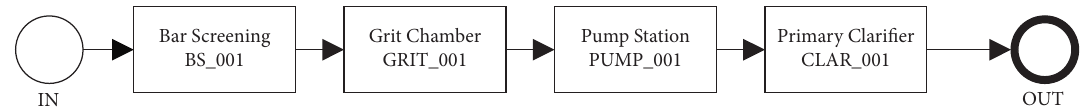
Figure 7: Graphical representation of modelling-immediate effect scenario.